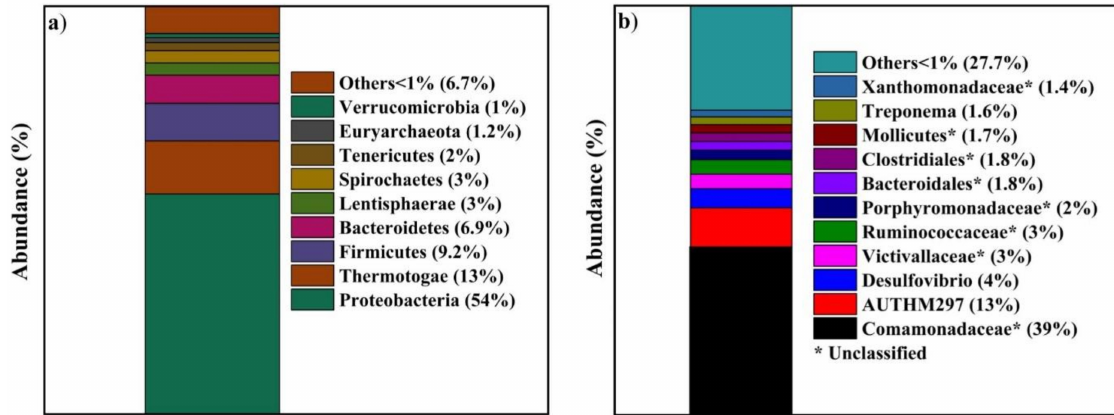
Figure 11. Microbial community in the mixed bacterial culture: ( a ) bacterial phyla and ( b ) bacterial genus